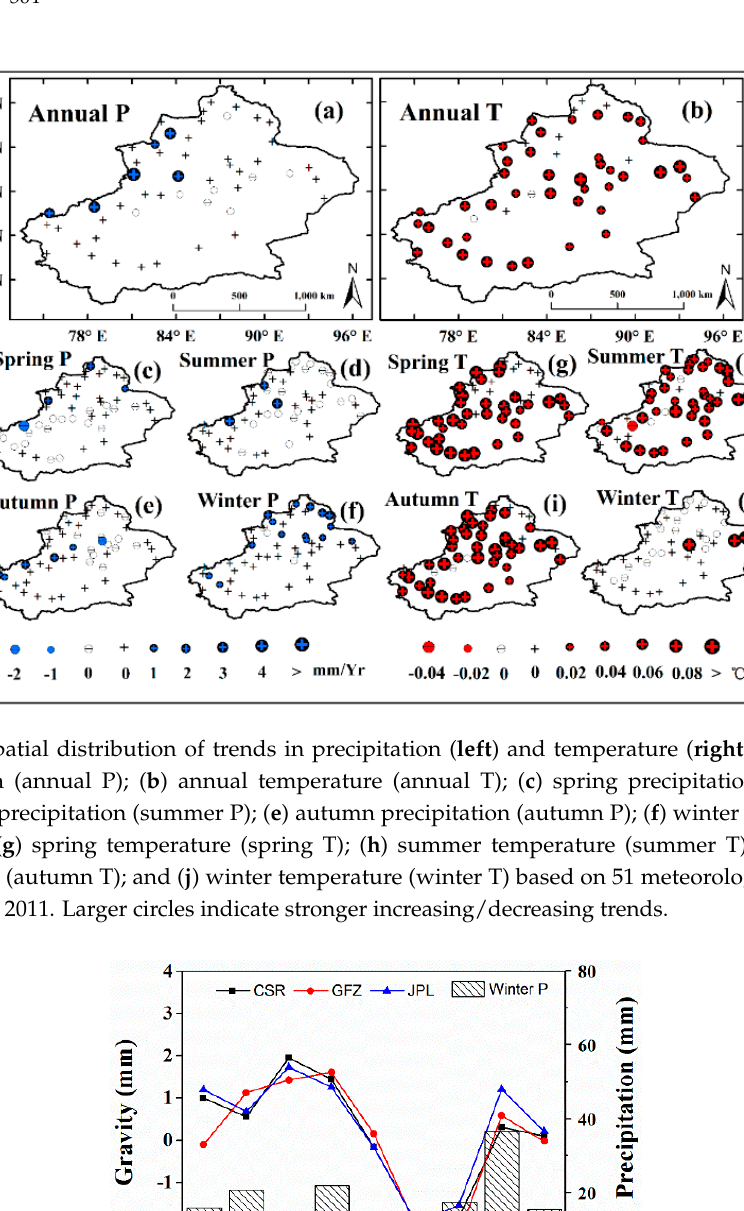
Figure 3. Spatial distribution of growing season NDVI trends from 1982 to 2011 over the Xinjiang region. Areas significant at the 95% level are presented.